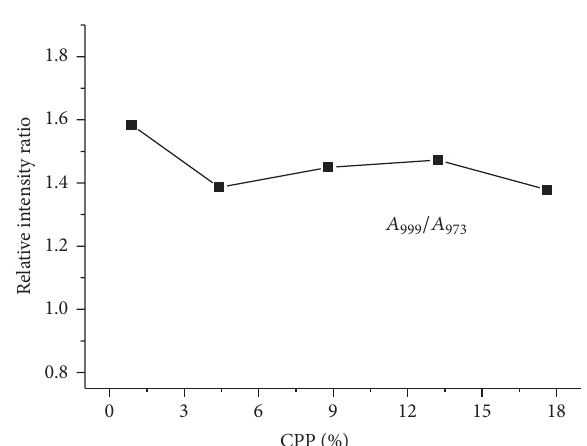
Figure 7: The relation between the ratio ( 𝐴 999 /𝐴 973 ) and CPP content.